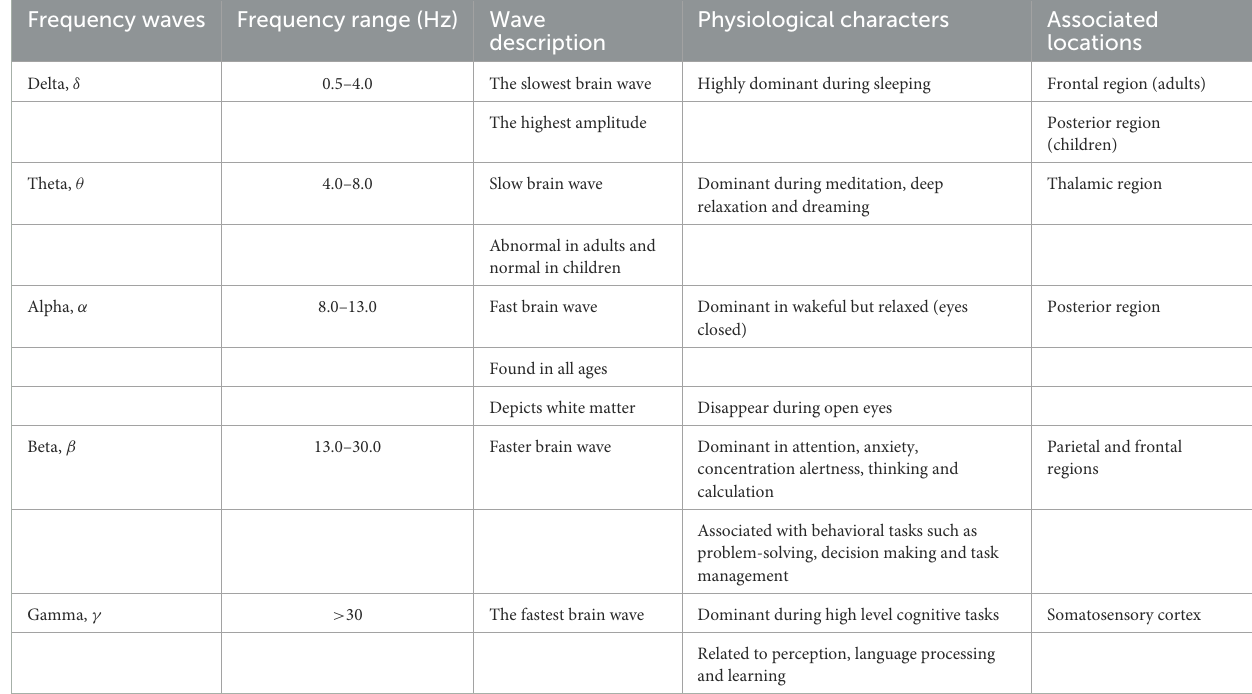
TABLE 1 Classification of brain waves and their description (Kumar and Bhuvaneswari, 2012; Ismail et al., 2016; Beppi et al.,